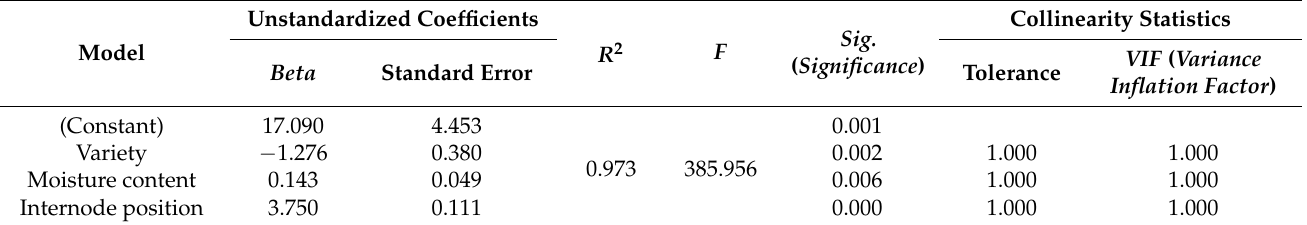
Table 1. Table of regression coefficients of the diameter of bunch